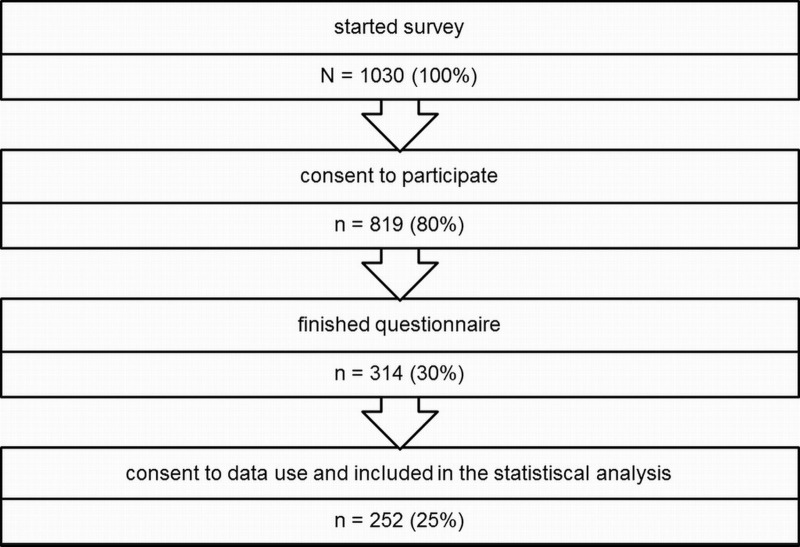
Participant flow chart.